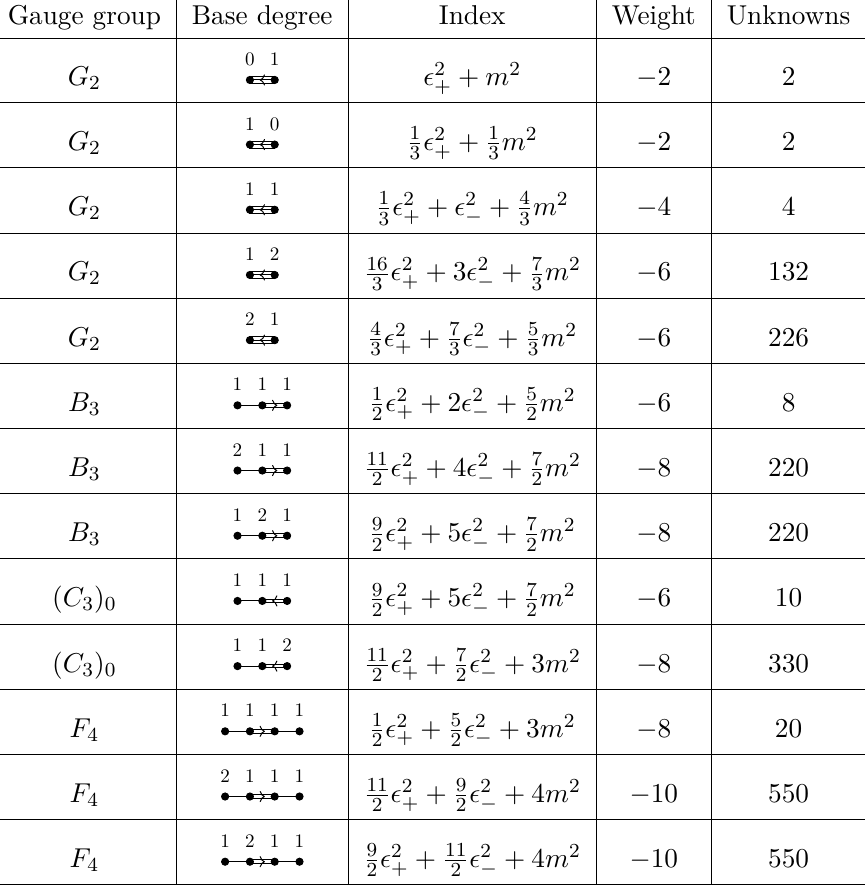
Table 5 . The index polynomial, weight and unknown coefficients for the numerator of the elliptic genera except ( C r ) π